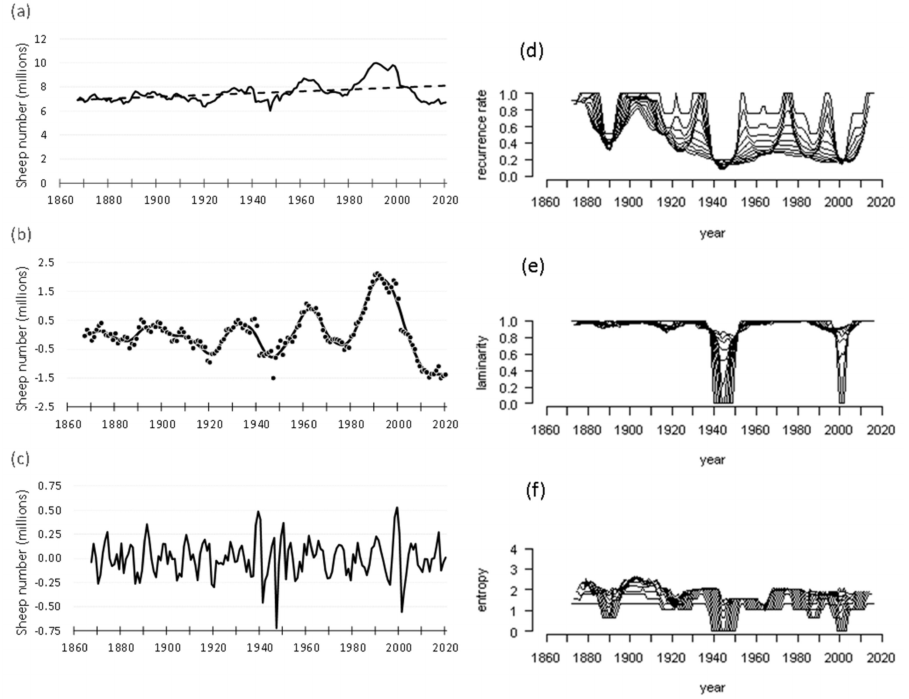
Figure 6. Time series analysis results and RQA results for sheep numbers in Scotland (1867–2020): ( a ) data and long-term trend, ( b ) deviation from long-term trend and smoothing spline, ( c ) residuals from long- and medium-term trends, ( d ) recurrence rate, ( e ) laminarity, and ( f ) entropy from RQA using sliding windows of 10–30 years duration in 2-year